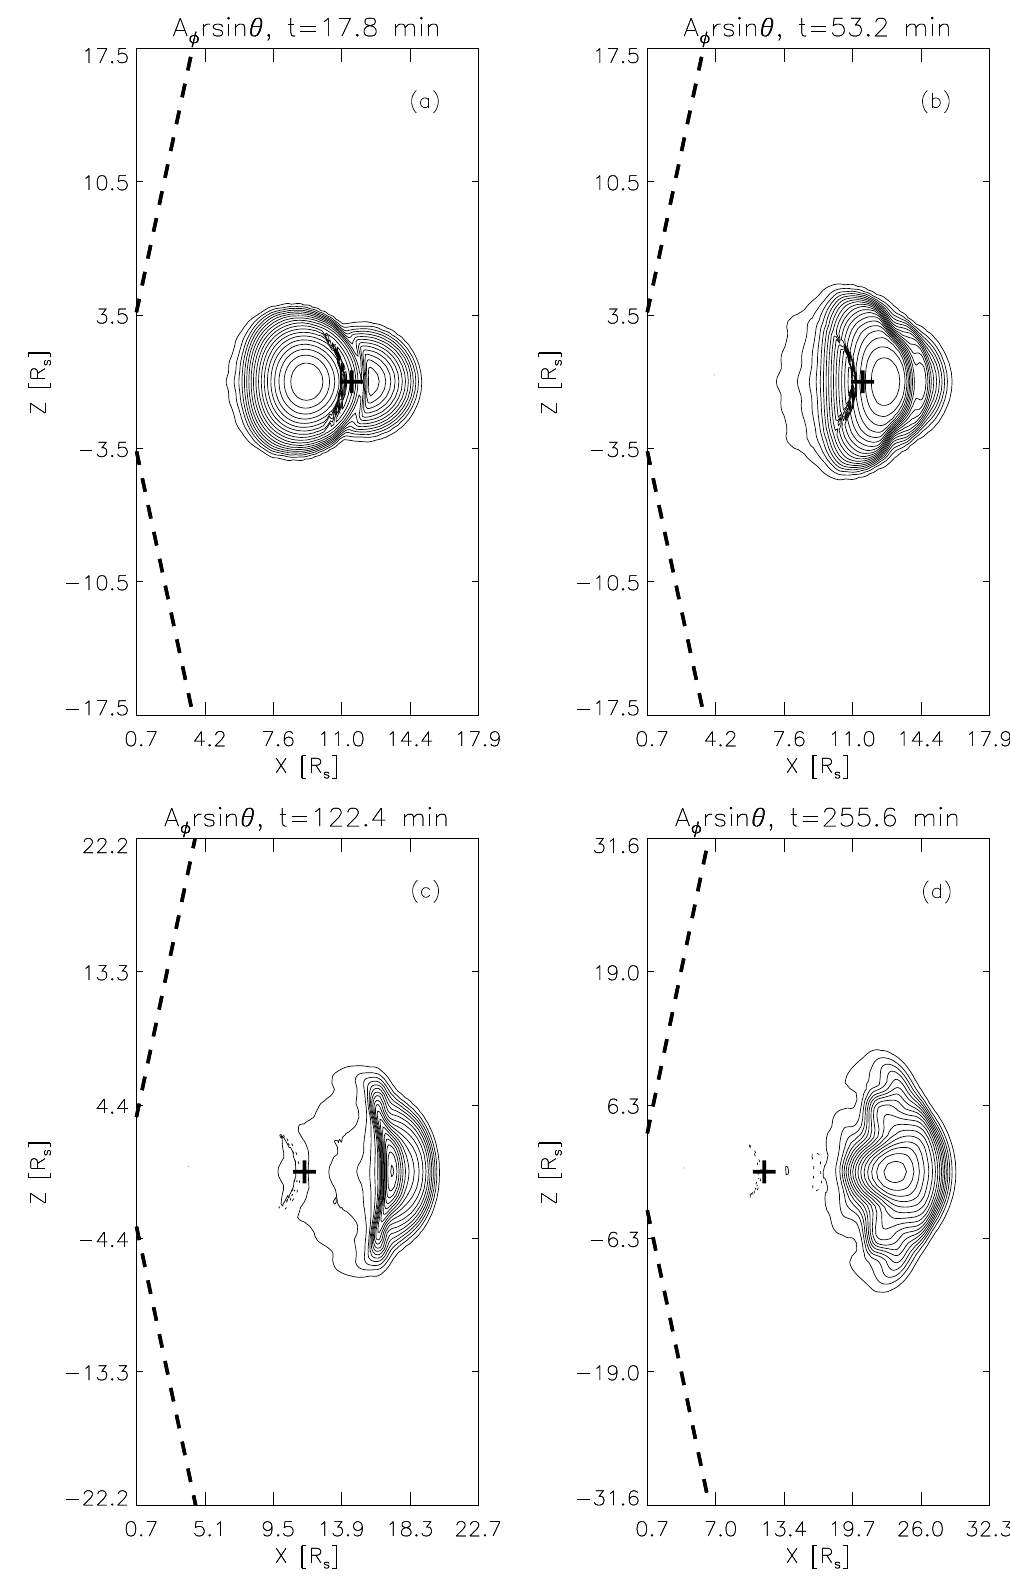
Fig. 6. As Fig. 4, except that two CMEs now begin their outward motion at the same meridional